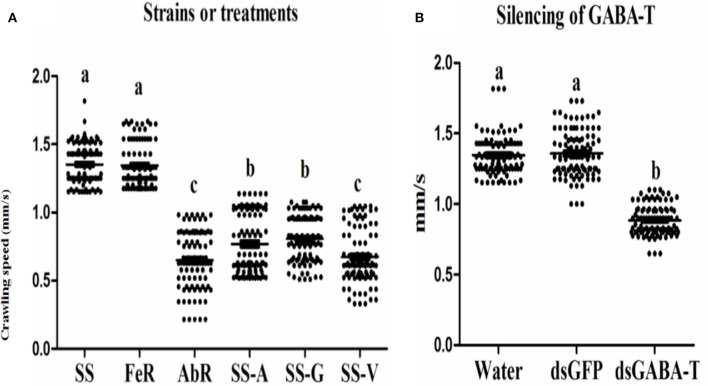
Scatter plot of crawling speed results of different strains and treatments (n = 100). The significant difference (P < 0.05) was indicated by letters. (A) Indoor strains, (B) wild strain.